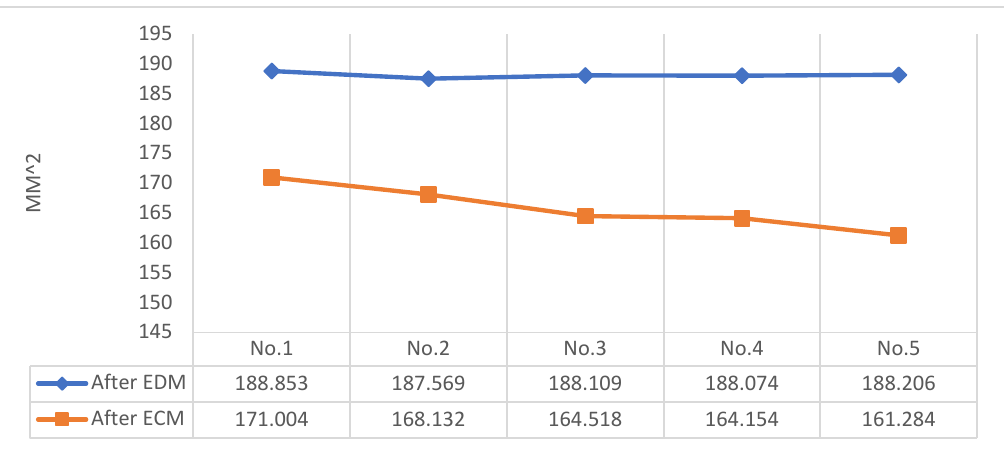
Figure 14. Comparison of the sixth level after ECM processing and EDM processing.